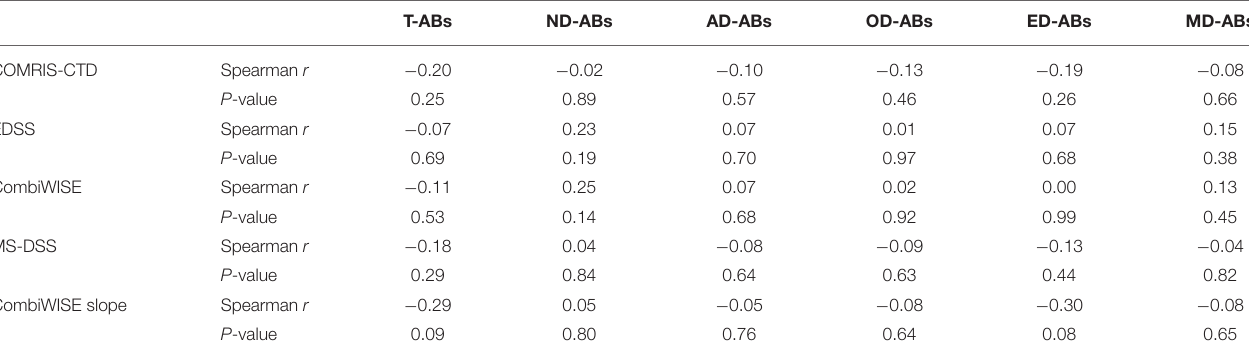
TABLE 2 | Correlation analysis (Spearman r and P -values) between adjusted total (T-ABs) and CNS cell-specific ABs (ND-ABs, neurons; AD-ABs, astrocytes; OD-ABs, oligodendrocytes; ED-ABs, endothelial cells; and MD-Abs, myeloid cells) in subjects’ CSF (ABs/ml CSF) and their clinical measures of CNS tissue destruction, disability, and